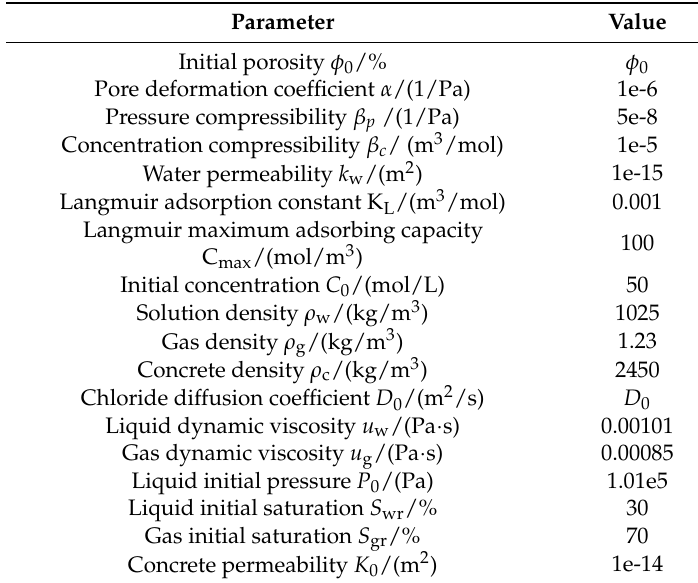
Table 6. Numerical simulation parameters.